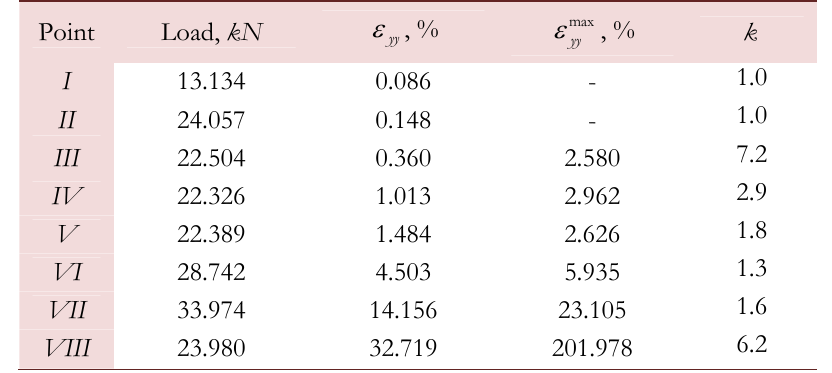
Table 2: Estimation of axial strain concentration, which is caused by localization of plastic yielding in material.